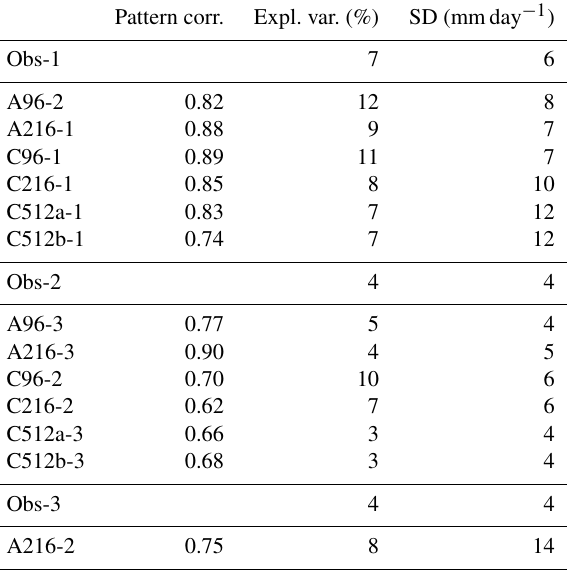
Table 2. Observed (Obs) and simulated (labeled by simulation name) EOT patterns in MJJASO (first column); numbers indicate the order of the EOT pattern. Linear pattern correlation coeffi- cient of simulated and observed precipitation anomalies (second column), explained space–time variance of the EOT pattern (third column), and standard deviation of the EOT time series (fourth col- umn). Pattern